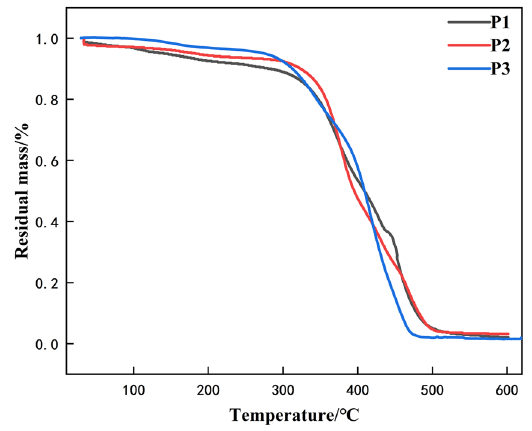
Figure 10: Thermogravimetric analysis of cured fi lm.